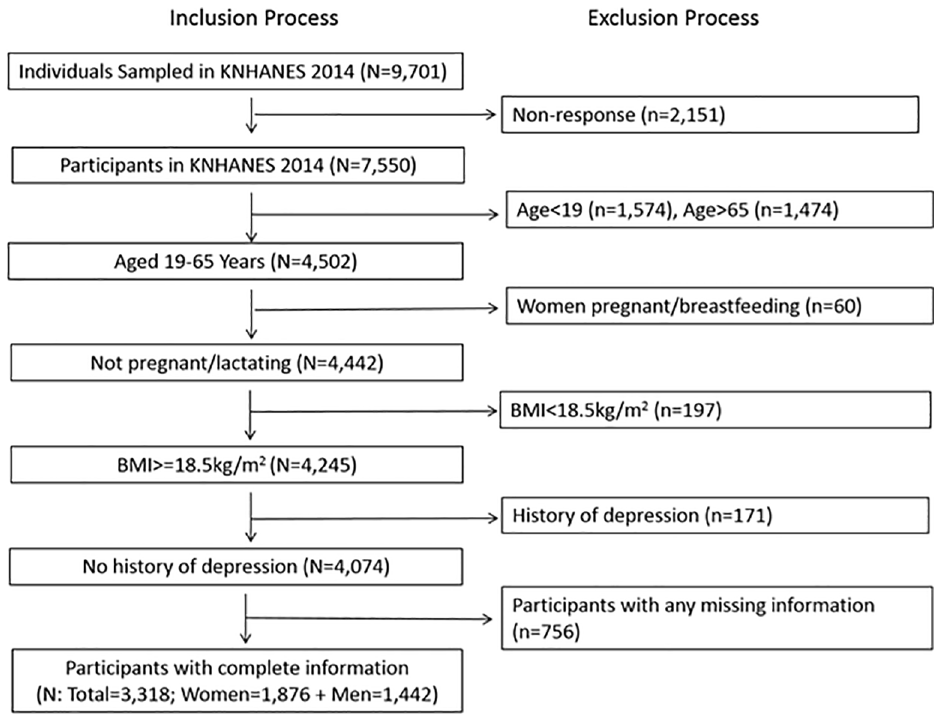
Fig 1. Inclusion and exclusion processes for the analytic sample from the Korea National Health and Nutrition Examination Survey (KNHANES) in 2014.